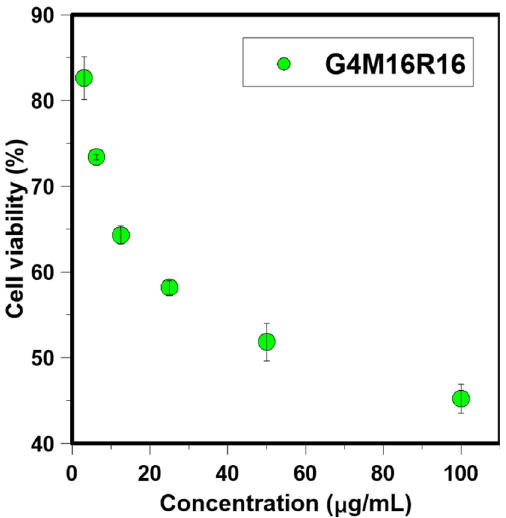
Figure 4. SH-SY5Y cells viability in presence of G4M16R16 pigment after 24 h.